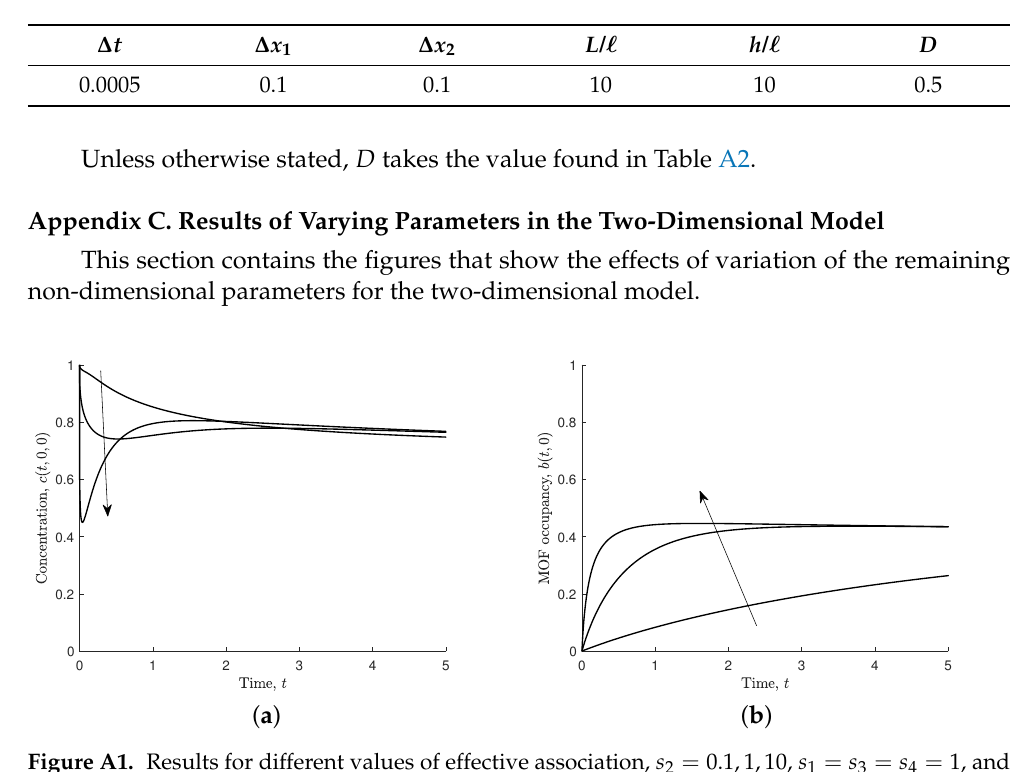
Figure A1. Results for different values of effective association, s 2 = 0.1,1,10, s 1 = s 3 = s 4 = 1, and D = 0.5. Arrows indicate the direction of increasing s 2 . ( a ) Non-dimensional concentration of ferric ions through MOF-mid point across two media, c ( t ,0, x 2 ) . ( b ) Non-dimensional MOF occupancy, b ( t ,0 )